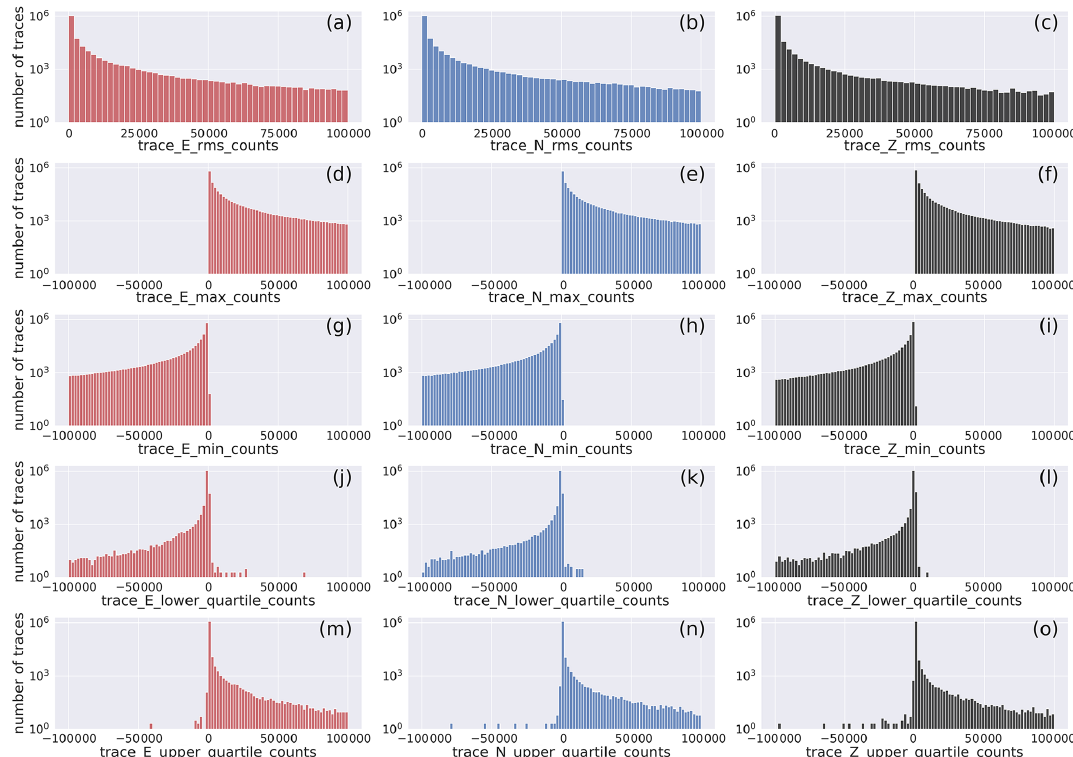
Figure 9. Histogram of the distribution of quality control metadata of the earthquake E -, N -, and Z -component waveform traces: rms, min, max, and first and third quartile. The width of the bins is 2 × 10 3 . The full distribution of values is provided in Fig. D3. The horizontal axis labels correspond to the metadata being represented which are listed in Table 2.